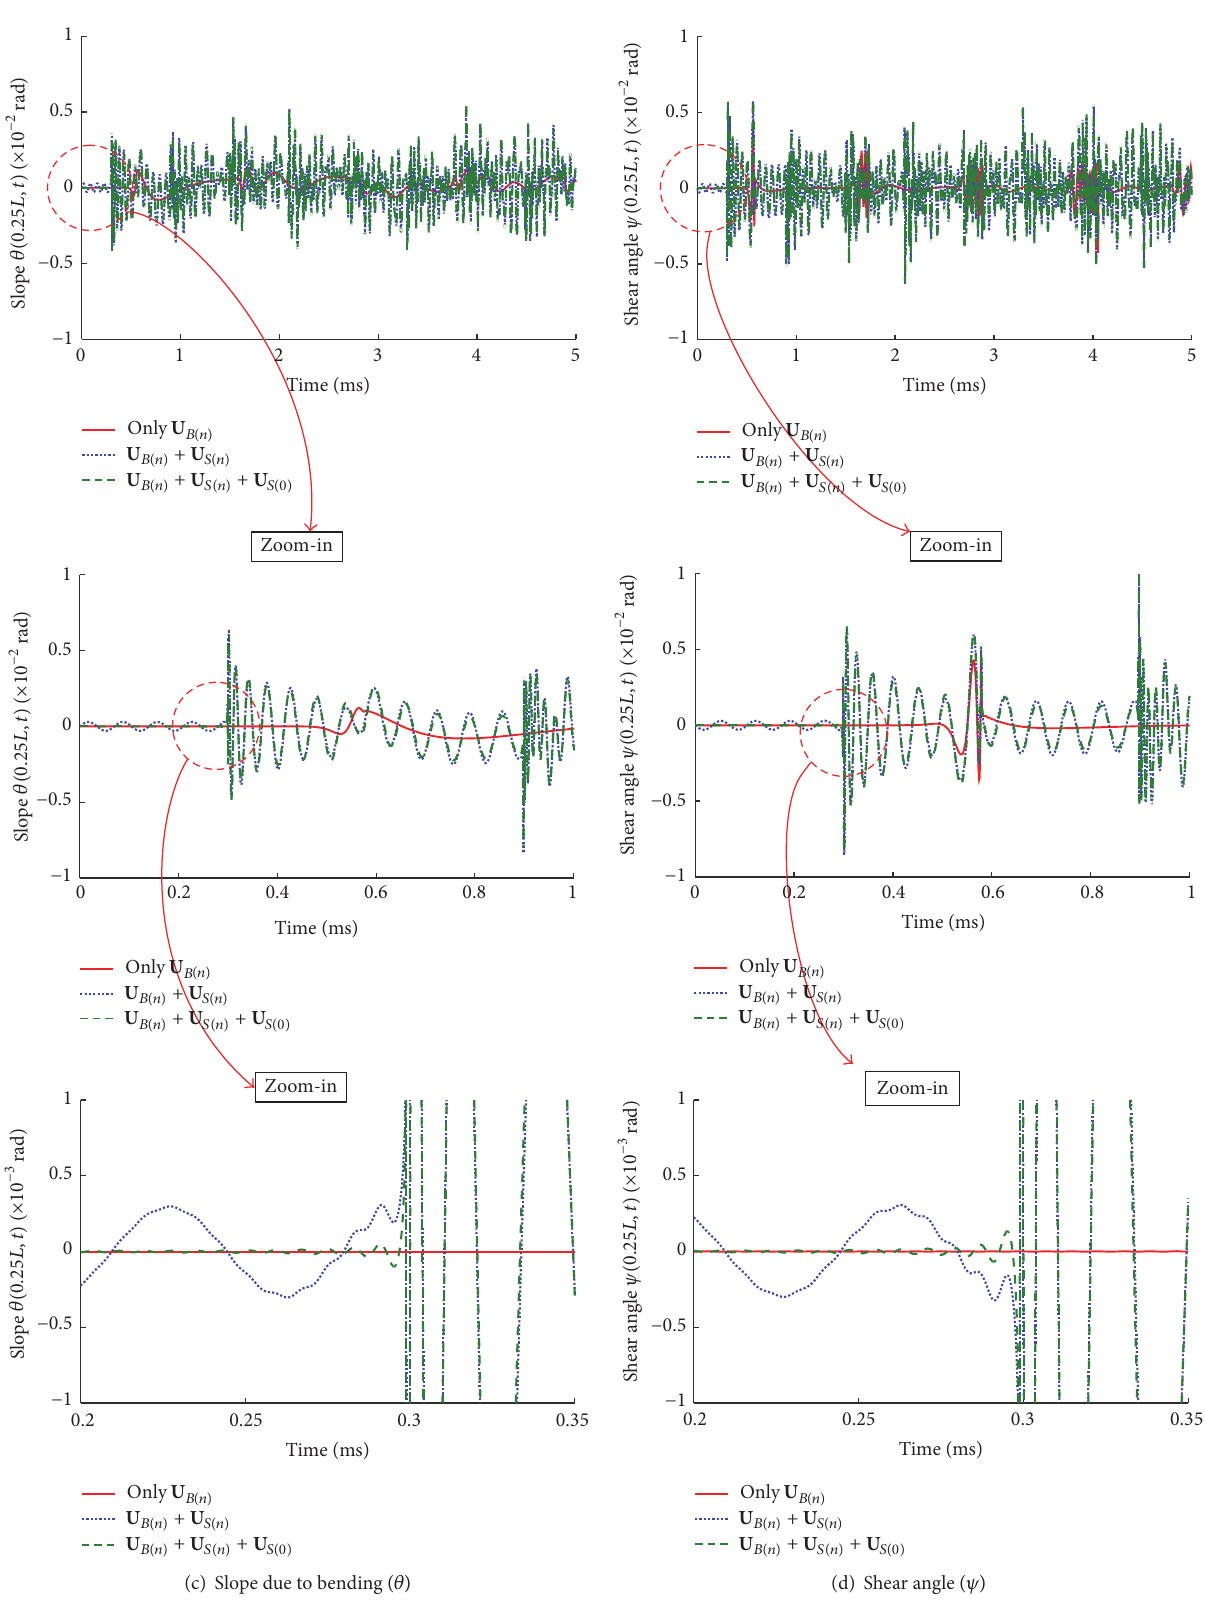
Figure 4: Dynamic responses at 𝑥/𝐿 = 0.25 of a simply supported beam subjected to a stationary impulsive point bending moment applied at 𝑥/𝐿 = 0.5 : (a) transverse displacement (𝑤) ; (b) total slope (𝑤 󸀠 ) ; (c) slope due to bending (𝜃) ; (d) shear angle (𝜓)